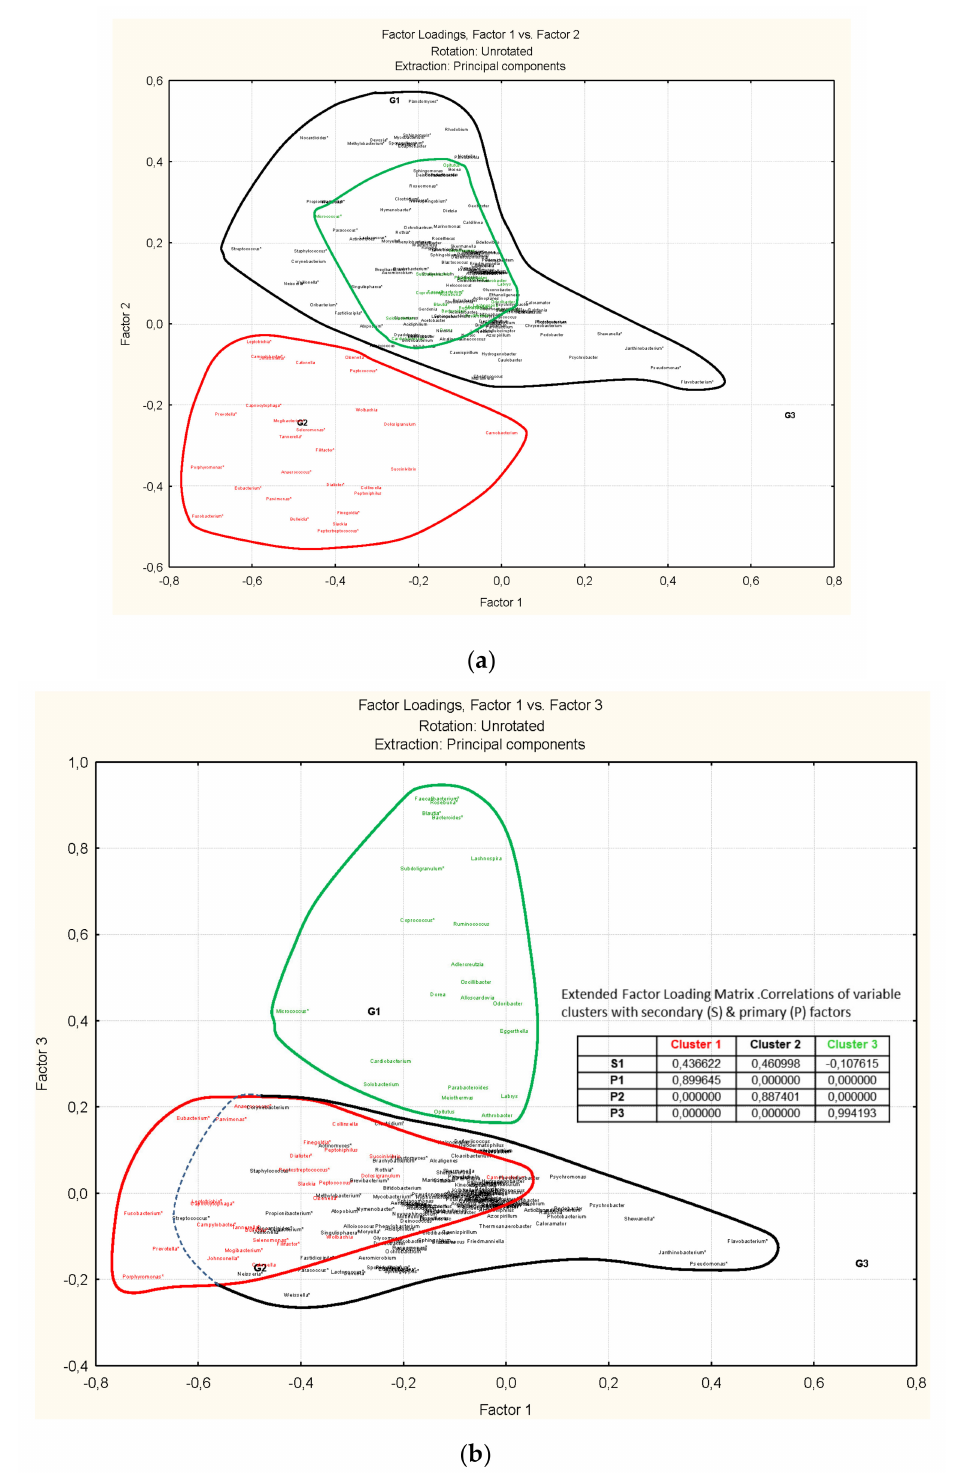
Figure 5. Factorial analysis considering the anisakids samples and bacteria at genus level. In the Factorial Space defined by Factor 1 vs. Factor 2 ( a ) and Factor 1 vs. Factor 3 ( b ) is disposed the correspondence with the classified clusters of Figure